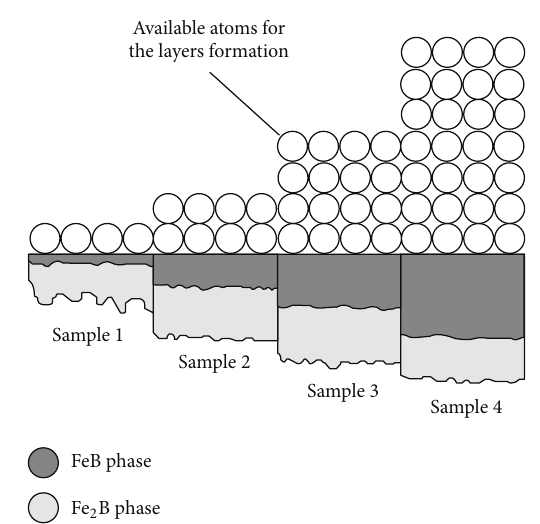
B phases as a function of the 2